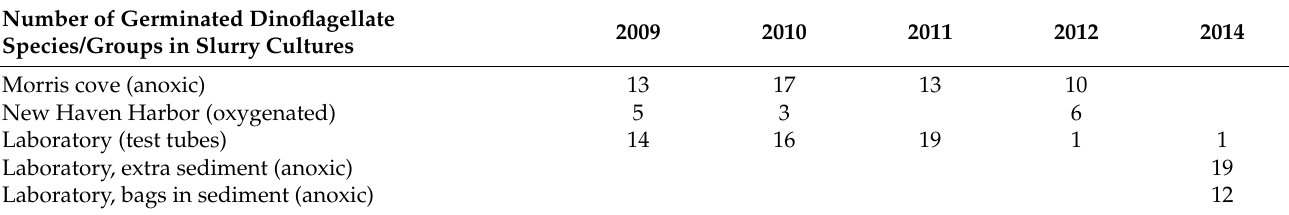
Table 2. The number of different morphological groups of vegetative cells observed in slurry cultures over time. “Bags” denotes the three bags that were kept inside a jar with sediment in the refrigerator until 2014 (6 years unopened). “Extra sediment” is the concentrated cyst fraction stored until 2014 in the same